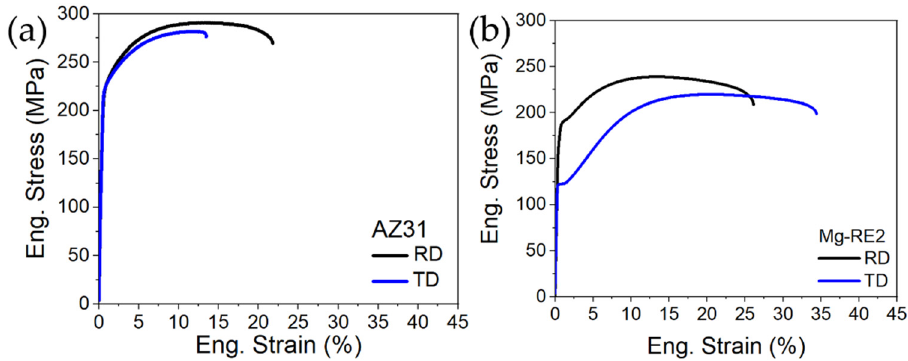
Figure 3. Engineering stress–strain curves of ( a ) AZ31 alloy and ( b ) Mg-RE2 alloy.